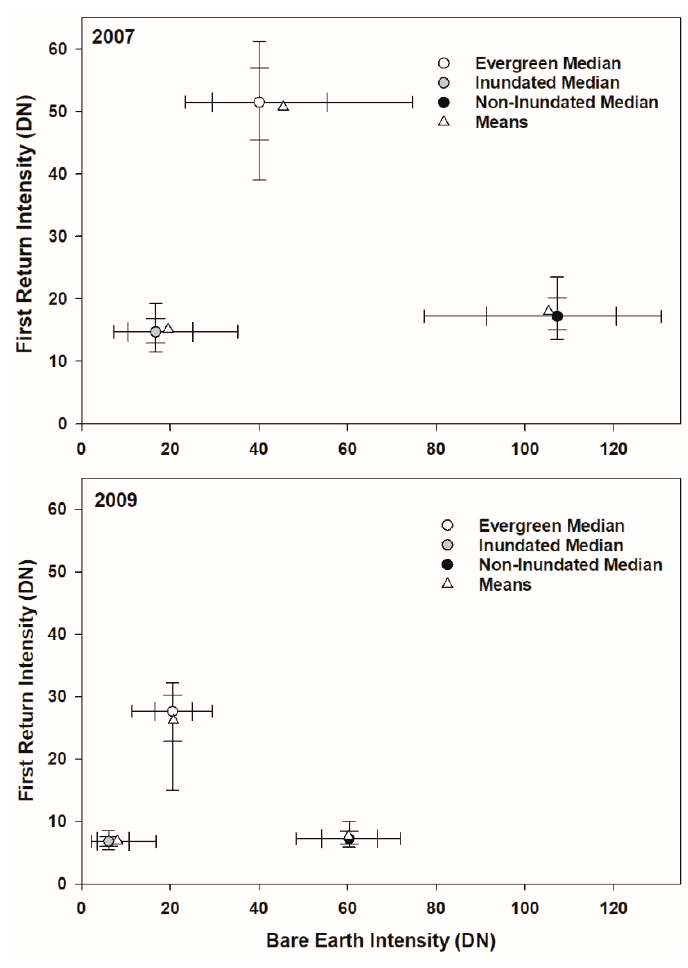
Figure 4. Scatterplot illustrating the median, mean, 10th, 25th, 75th, and 90th percentiles for evergreen, non-inundated deciduous and inundated deciduous region of interest (ROI) values extracted from the 27 March, 2007 ( top ) and 24 March, 2009 ( bottom ) bare earth (x-axis) and first return (y-axis) intensity images as digital numbers (DN). Note that the two deciduous classes have similar first return values, but markedly di ff erent bare earth returns, while the evergreen values are more similar to the inundated deciduous bare earth values but have markedly di ff erent first return values.